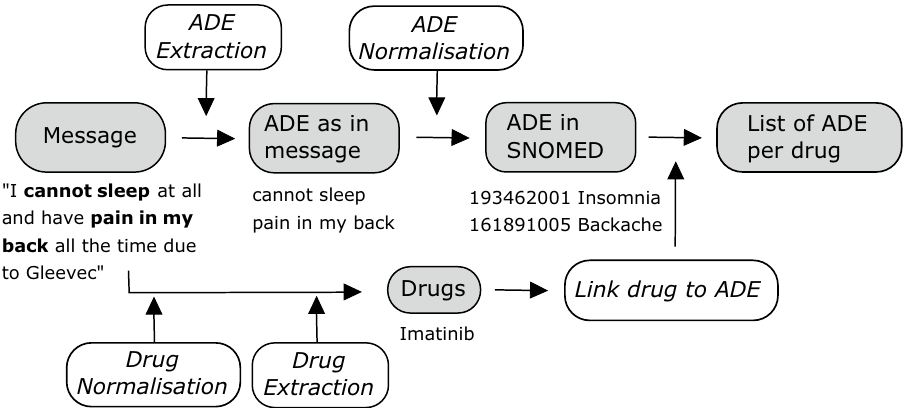
Figure 1. An overview of the software pipeline we developed for automatically determining which adverse drug effects (ADE) are mentioned on a patient forum. All italicized parts indicate modules we developed. An example message is provided to clarify each step. ADE: adverse drug